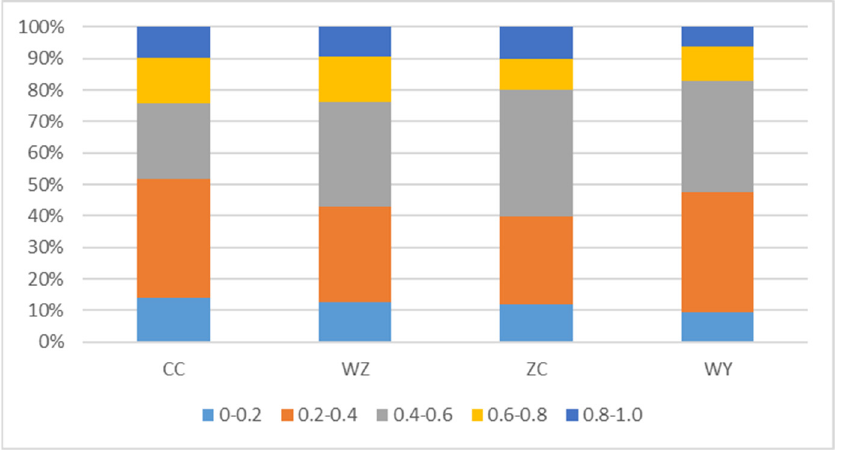
Figure 7. Percentage of different vegetation coverage on coal gangue piles.